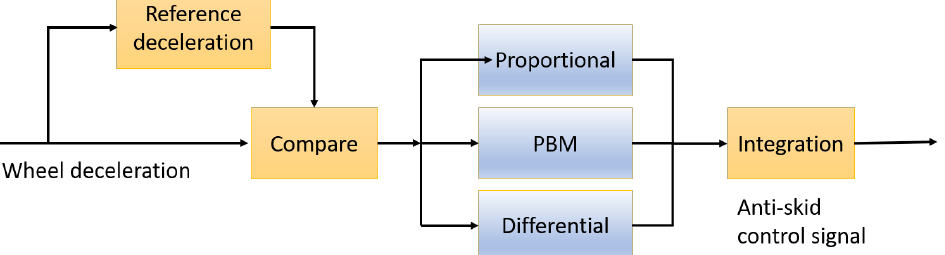
Figure 3. Schematic diagram of a slip-velocity-controlled PBM control system.